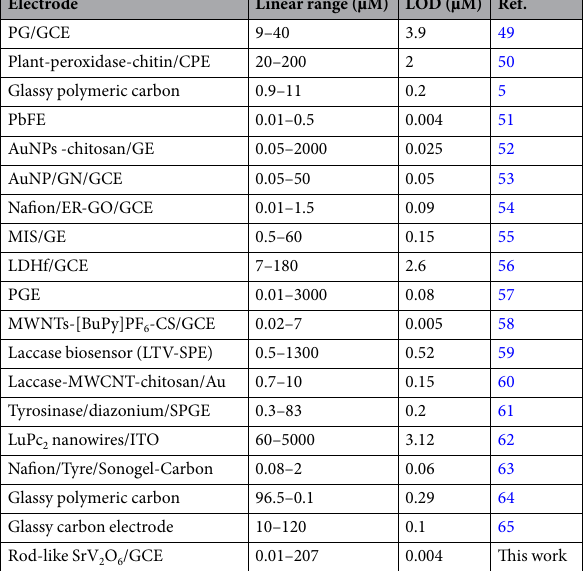
Table 1. Comparison of the analytical performance for proposed method with other reported chemically modified electrochemical detection of CA. Abbreviation: PG-Poly(glutamic acid; GCE-glassy carbon electrode; CPE-carbon paste electrode; PbFE-lead film electrode; AuNPs-colloidal gold nanoparticles; GE-gold electrode; GN-graphene Nanosheets; ER-GO-electrochemically reduced graphene oxide; MIS-molecularly imprinted siloxanes; LDHf-layered double hydroxide film; PGE-pencil graphite electrode; MWCNT- Multiwalled Carbon Nanotubes; [BuPy]PF 6 -Butylpyridinium Hexafluorophosphate; CS- Chitosan; LTV- Laccase ( Trametes versicolor ); SPE- Screen printed electrode; Au- Gold sheets electrode; SPGE- Screen printed gold electrode; LuPc 2 -Lutrium bisphthalocyanine; ITO- Indium tin